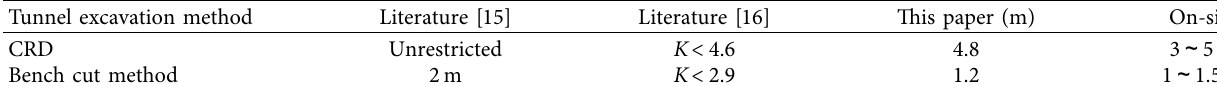
Table 4: Calculation of the unsupported span.